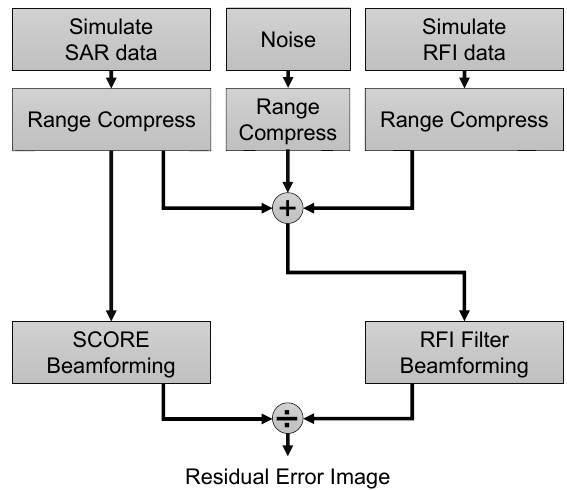
Figure 16. Simulation chain for the performance evaluation of the RFI mitigation. The simulated SAR and RFI data are range compressed individually. The range-compressed SAR data is then beamformed with SCORE to create the ideal reference data. Contaminated data is produced by summing the range-compressed SAR and RFI data. The contaminated data is then corrected using the algorithms. In the end, the algorithm output is divided by the reference data to produce the residual error